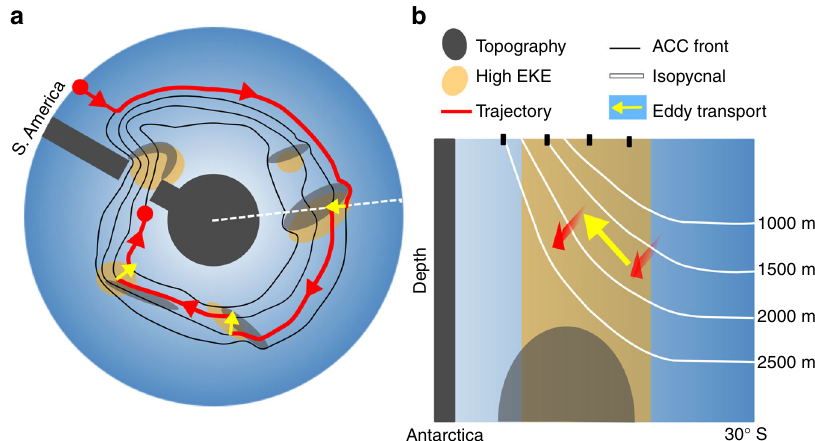
Fig. 7 Idealized schematic illustrating the effect of eddy advection at topographic hotspots on upwelling pathways. a An idealized particle trajectory ( red ) follows time-mean Antarctic Circumpolar Current (ACC) streamlines ( black ) that fl ow southeastward around Antarctica from east of Drake Passage ( blue surface indicating the particles ’ isopycnal surface, lighter color indicating shallower depths). The trajectory crosses streamlines and upwells ( yellow arrows ) in regions of high eddy kinetic energy (EKE; yellow shading ) at major topographic features ( gray shading ). This creates a superimposed southward/upward spiral as the particles shift southward and upward each time they encounter a region of high EKE. b A two-dimensional vertical cross-section of the Southern Ocean from Antarctica to 30° S, indicated by the white dashed line in a . White lines show idealized isopycnal layers shoaling and thinning toward the South. The red arrows show the trajectory entering the high EKE region associated with topography along the northernmost ACC front and exiting the region, shallower and further south (front positions indicated by dotted lines